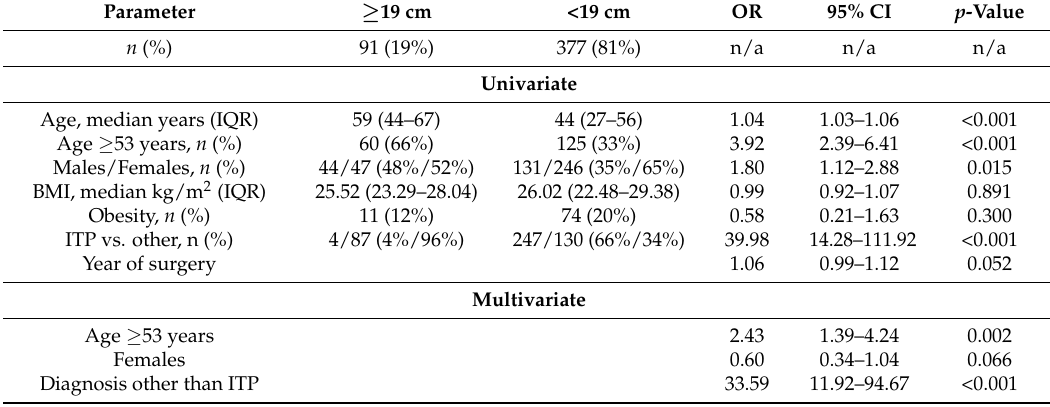
Table 4. Risk factors for spleen ≥ 19 cm in